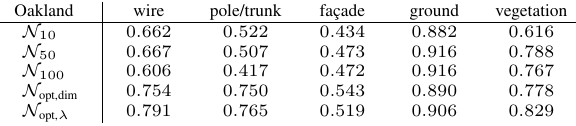
Table 2: Recall values for QDA-based classification using all fea- tures and different neighborhood definitions.